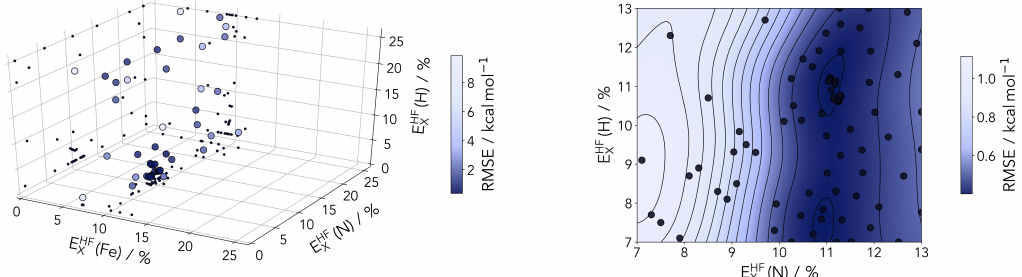
Figure 6. ( Left panel ) sampled points during Bayesian optimization of the HF-exchange percentages for the three atom types. The points are color coded according to the root mean-square error (RMSE) between the computed to the coupled cluster reference. ( Right panel ) 2D-cut of the posterior distribution (at a fixed 9% HF-exchange for Fe) after 80 sampled points. A valley around 11% is clearly identifiable for the N atom